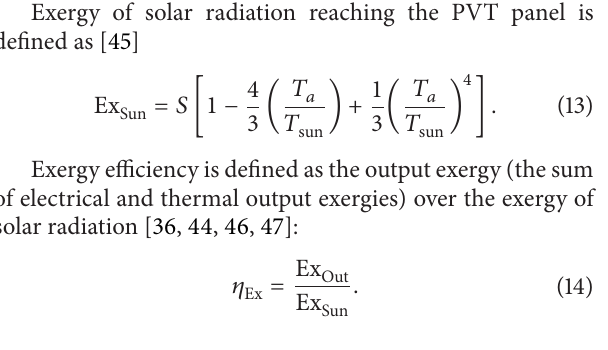
same trend as Figure 5 for the packing factors 0.3, 0.5, 0.7, and